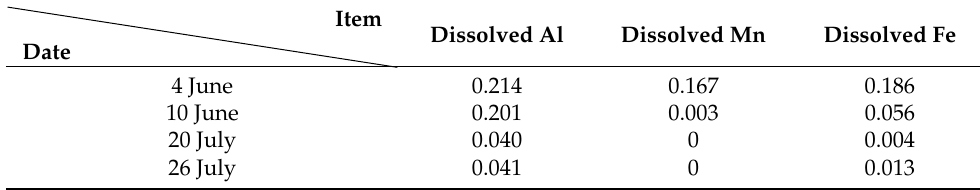
Table 3. Water quality of the outflow channel (in units of mg/L).